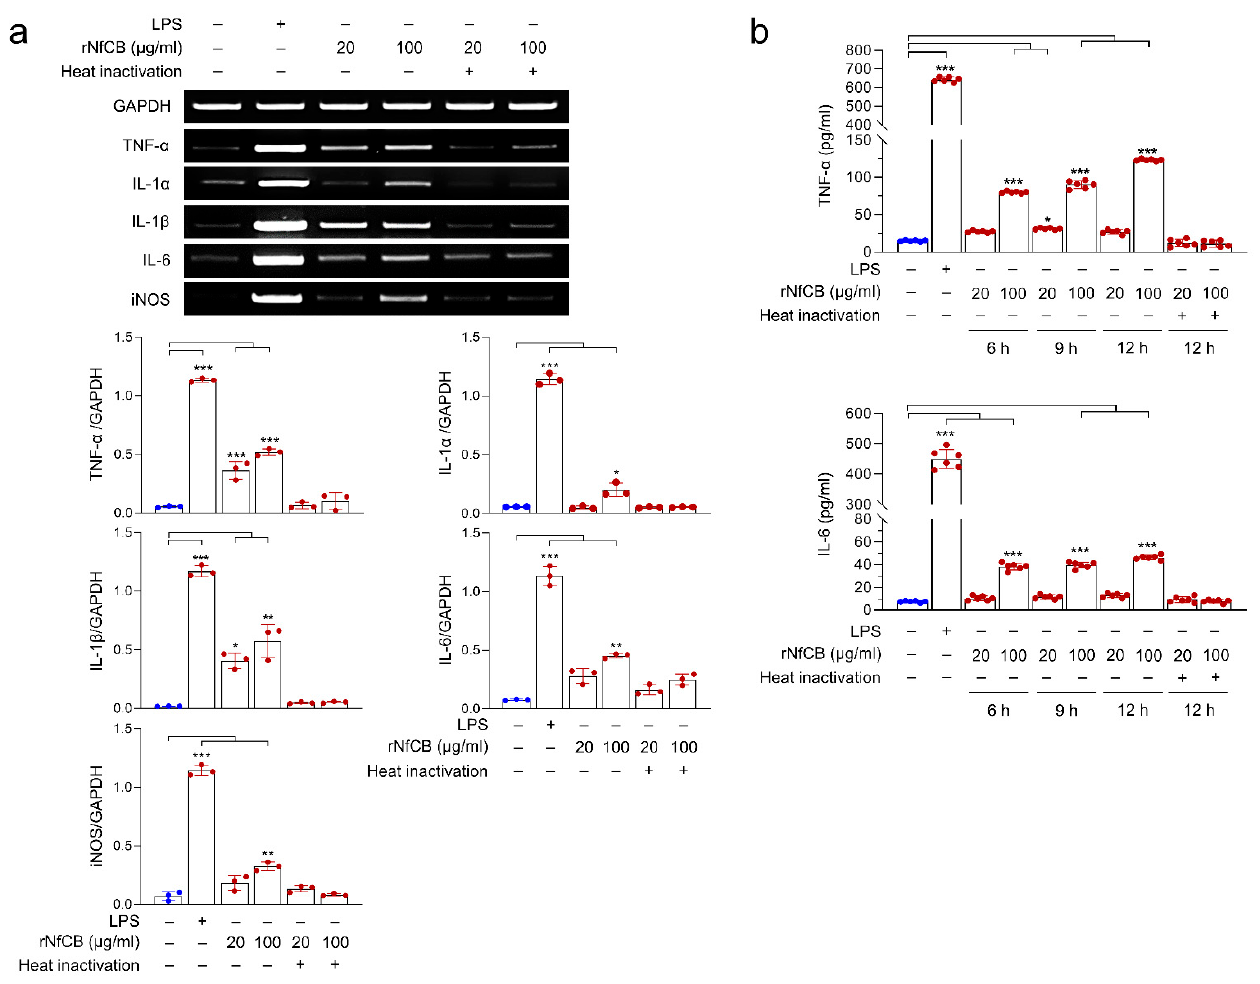
Figure 3. rNfCB induces production of pro-inflammatory cytokines in BV-2 microglial cells. ( a ) mRNA expression. BV-2 microglial cells were treated with different concentrations (20 µg/mL or 100 µg/mL) of active and heat-inactivated rNfCB. Cells were harvested at 6 h after treatment. Semi-quantitative RT-PCR was performed to analyze expression patterns of cytokines (TNF- α , IL1- α , IL-1 β , and IL-6) and iNOS. Bar graphs indicate the quantitative expression profile of each gene, represented as -fold induction of each gene relative to GAPDH in three independent experiments. ( b ) Quantitative ELISA. BV-2 microglial cells were treated with different concentrations (20 µg/mL and 100 µg/mL) of rNfCB for different time points (6 h, 9 h, or 12 h). Heat-inactivated rNfCB was administered to the cells for 12 h. At indicated time points, the supernatant was collected and protein levels of TNF- α and IL-6 were analyzed via ELISA. Values were presented as mean ± SD of three independent experiments. One-way ANOVA with Dunnett’s post hoc test was performed as multiple comparisons with the negative control without treatment, with either LPS or rNfCB. *** p < 0.0001, ** p < 0.001, * p < 0.01.